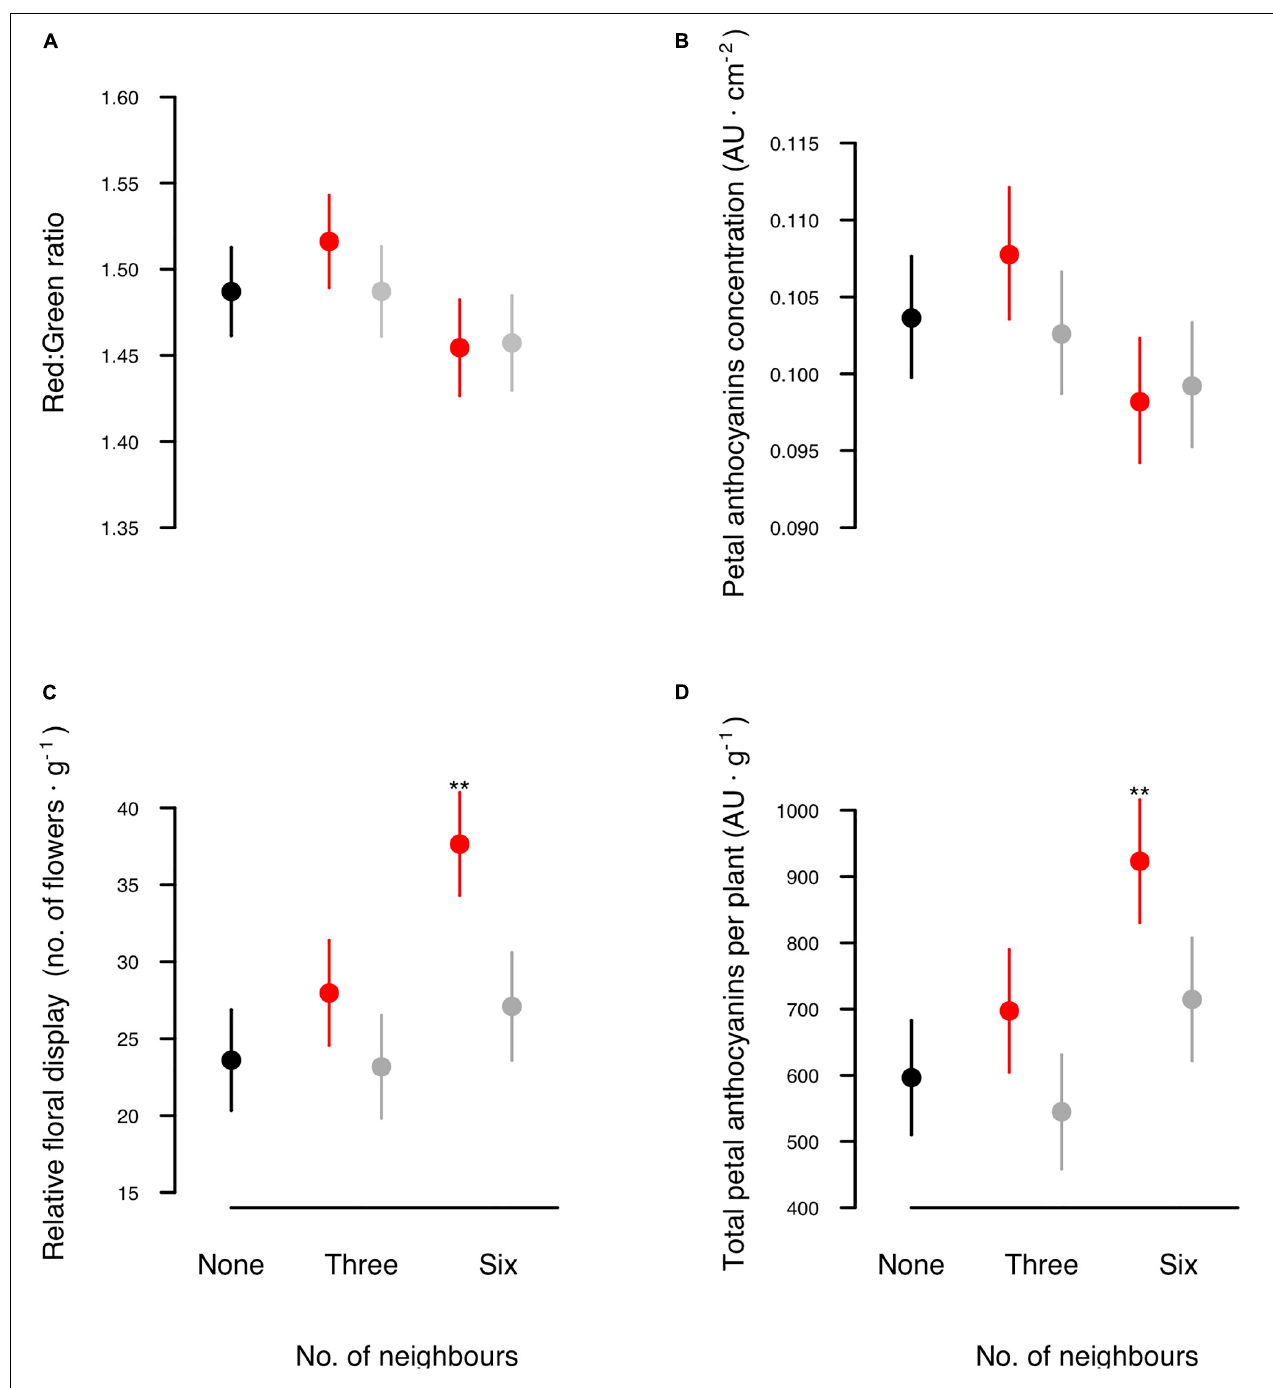
FIGURE 2 | Effect of the relatedness of neighbours on floral colour and anthocyanin allocation. Shown are least-square means ( ± SEM) of (A) red:green ratio; (B) petal anthocyanin concentration (AU cm − 2 ); (C) individual relative floral display (number of flowers g − 1 ); and (D) total petal anthocyanins per plant (AU g − 1 ). Focal plants were grown either alone (black dots), with three neighbours, or with six neighbours, which were either kin (red dots) or non-kin (grey dots). Asterisks above dots highlight significant differences against control plants without neighbours ( post hoc comparison of LMM analysis, P < 0.01, Supplementary Table 2 ).